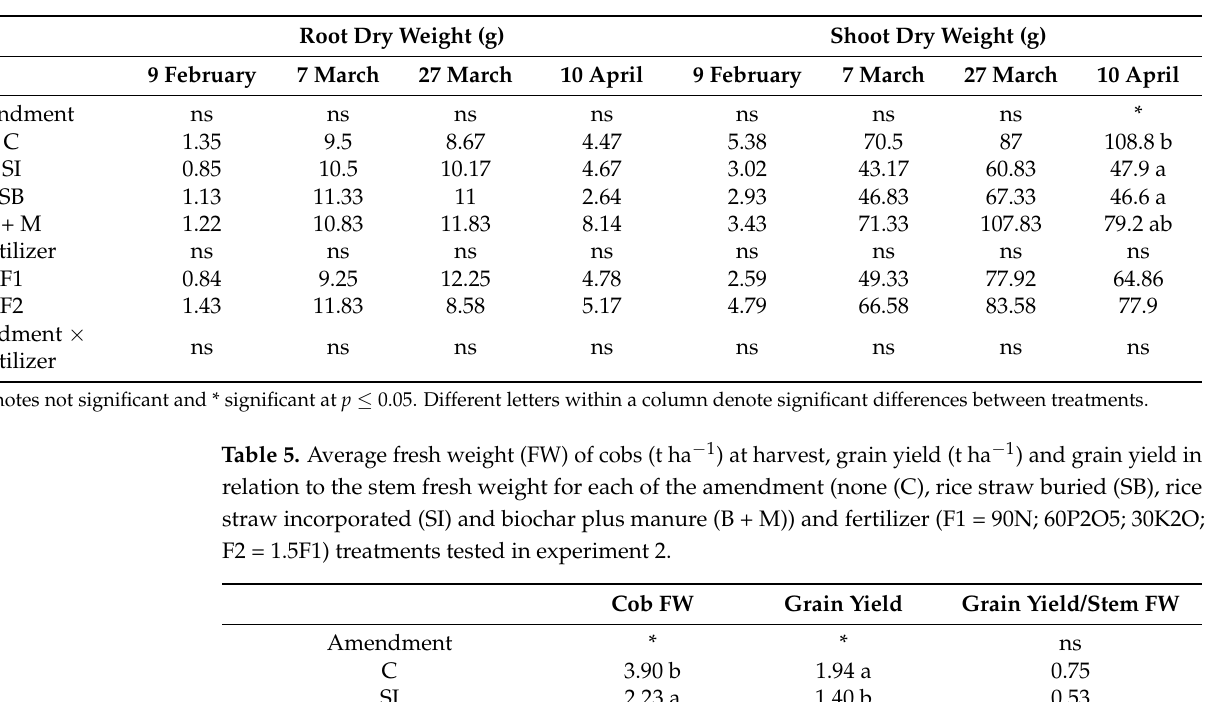
Table 4. Average maize root and shoot production in experiment 2 as a function of organic matter treatment and fertilizer rate.